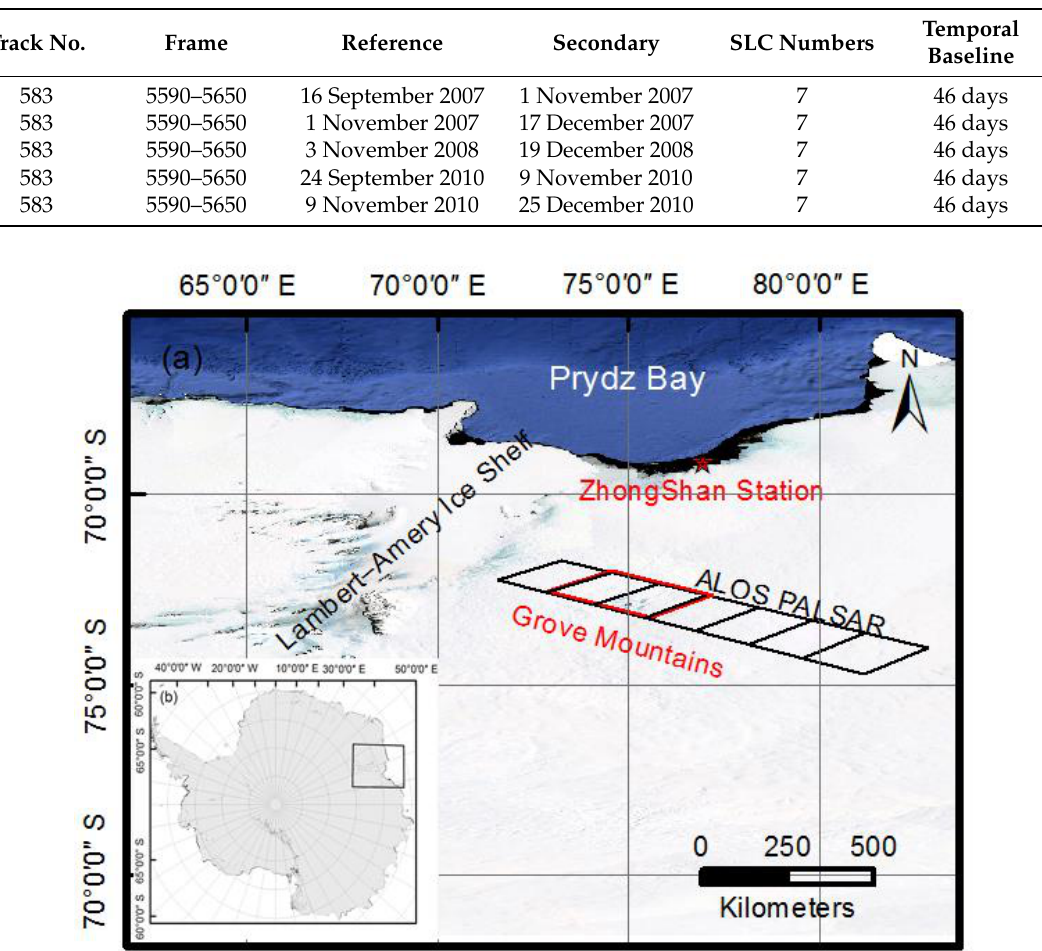
Table 1. ALOS PALSAR data information of application on the experiment.